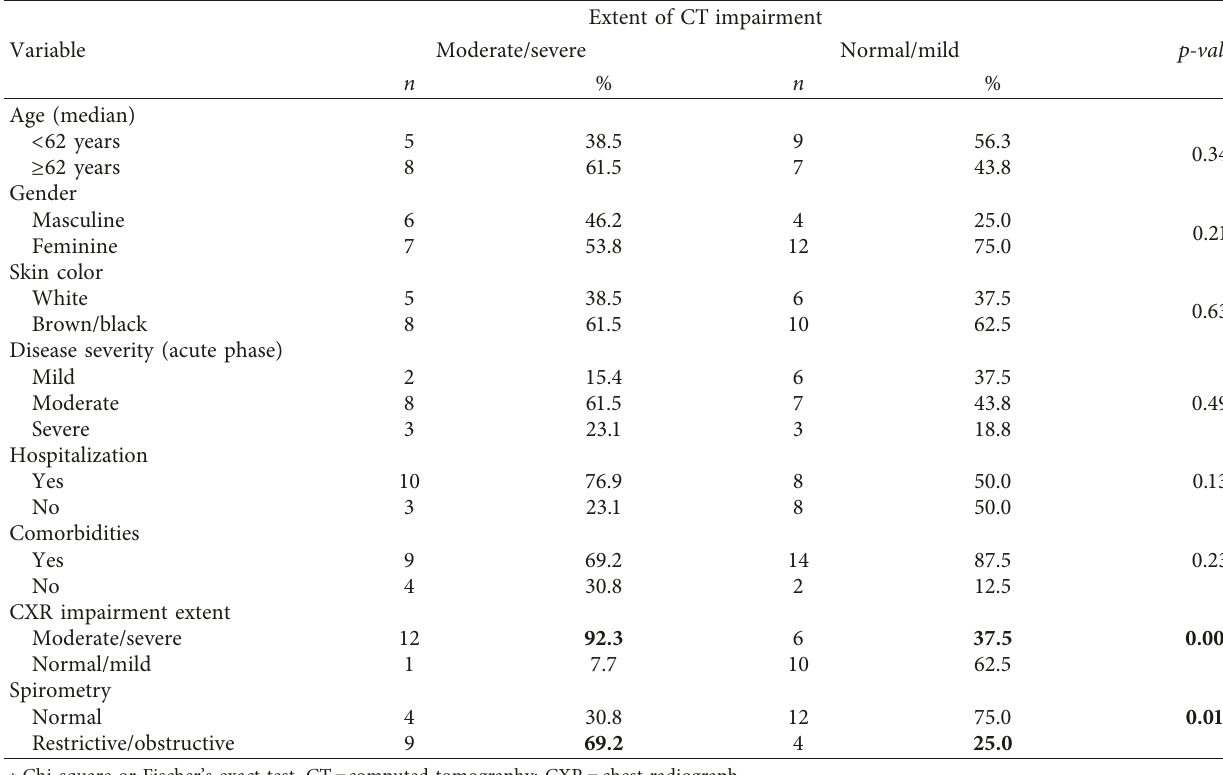
Table 1: Correlation of several variables with the extent of CT impairment ∗ .